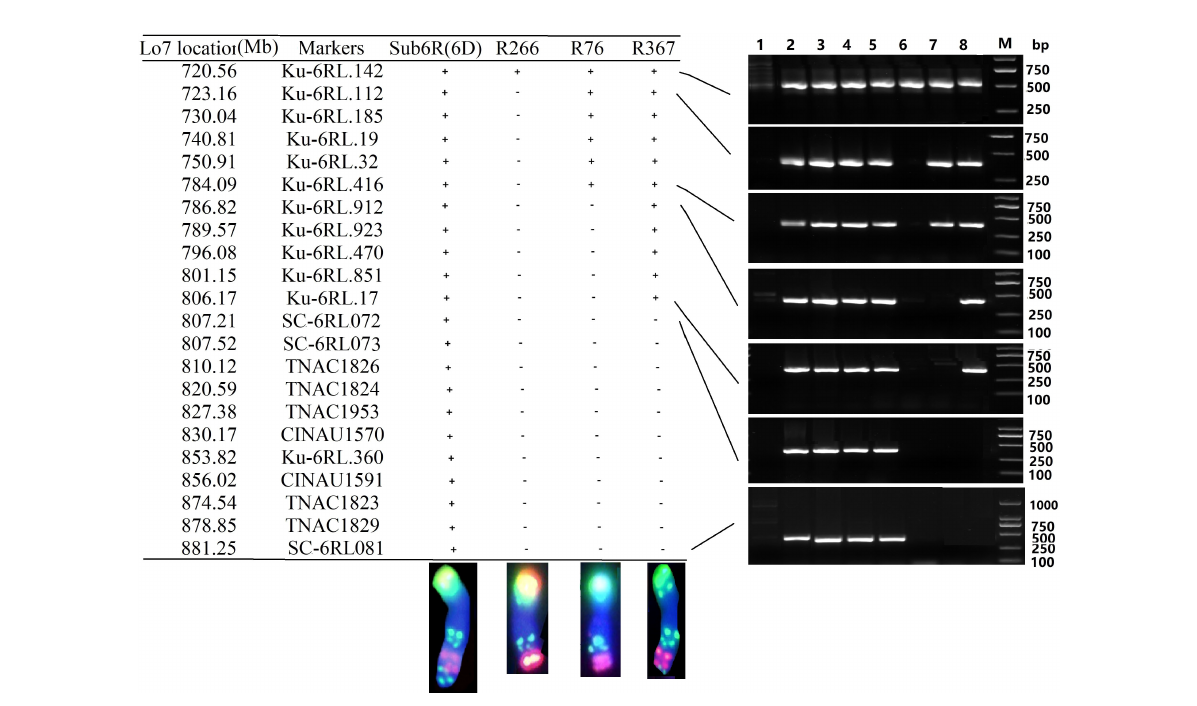
FIGURE 4 Physical locations of chromosome-speci fi c markers on Sub6R(6D), 6RL deletion lines R266, R76, and R376. The marker location (left) was determined in reference to the genome of Lo7 (Mb). “ + ” represents ampli fi cation, while “ - ” represents no ampli fi cation of 6RL speci fi c bands. The plant materials 1-8 used (right) were CS, Weining rye, T-701, Sub6R(6D), R23, R266, R76, and R367. The chromosomes were subjected to ND-FISH using Oligo-pS119.2 (green) and Oligo-pSc200 (red).